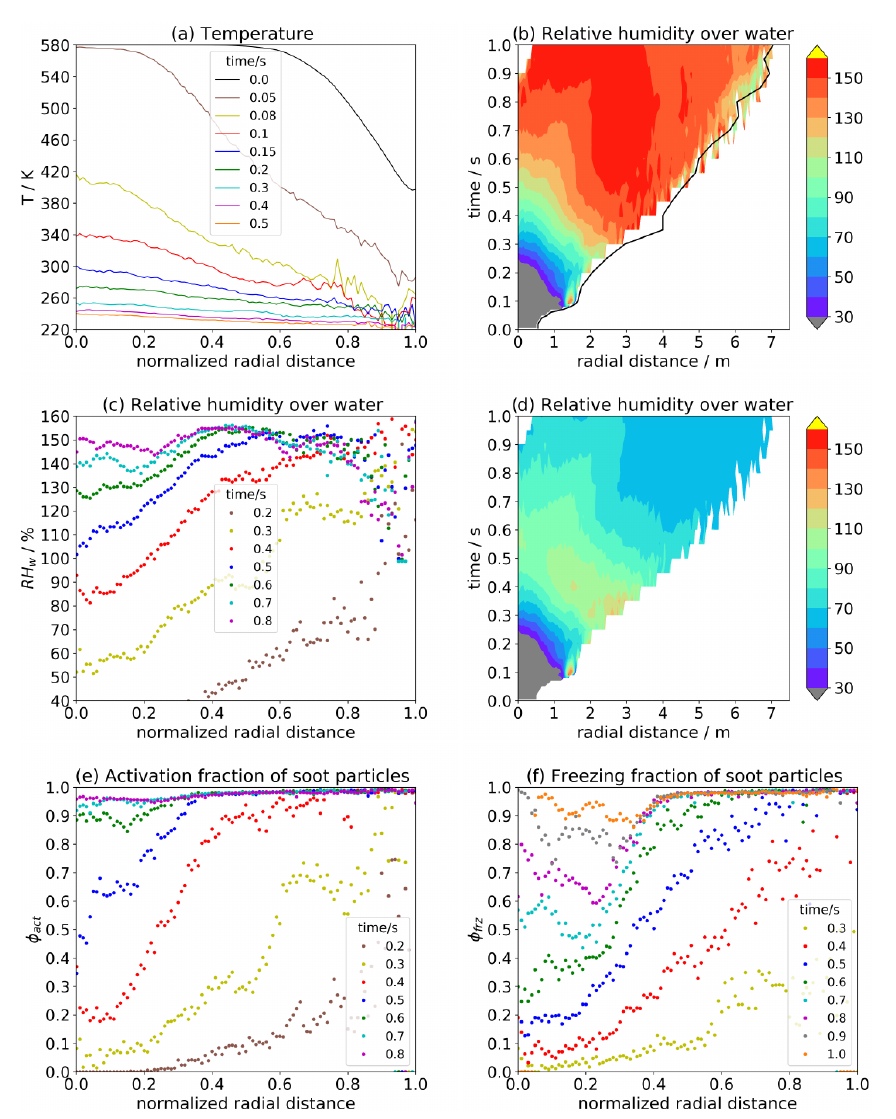
Figure 1. Radial profiles of (a) temperature and (b–d) relative humidity over water RH liq in percent, (e) fraction of soot particles activating into water droplets φ act and (f) freezing to ice crystals φ frz . Whereas panels (a–c) show results from a simulation with switched-off contrail microphysics, panels (d–f) show results from the baseline case with switched-on contrail microphysics. The contour plots in (b, d) show RH liq over ( r,t ) space, where r is the absolute radial distance from the plume centre. The black line in (b) indicates the increasing plume radius r p over time. All other panels show line plots at different plume ages (indicated by the legend), where the horizontal axis uses the normalized radial distance ˜ r = r/r p as